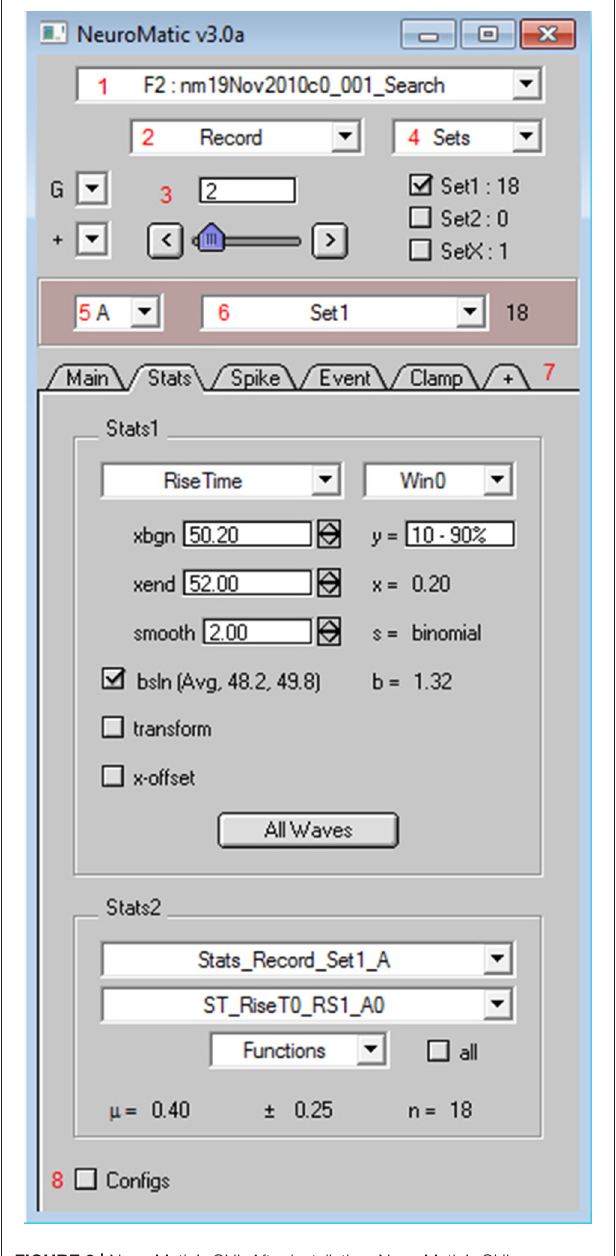
FIGURE 2 | NeuroMatic’s GUI. After installation, NeuroMatic’s GUI automatically appears once Igor starts. Red numbers (added to this screen capture) denote GUI controls of interest: (1) The folder select is used to specify which NeuroMatic data folder to analyze, or to execute a folder function such as Open, Save or New. NeuroMatic data folders contain acquired/simulated/imported waves, plus all variables, waves and subfolders necessary to run NeuroMatic. (2) The wave-prefix select is used to specify which waves in the selected folder are to be processed. For example, “Record” selects waves named “RecordA0,” “RecordA1,” etc. Selected waves are sorted alphanumerically via their channel letter (e.g., “A”) and sequence number (0, 1, 2, etc.). (3) The wave-number select controls (set-variable, slider, < > buttons) are used to specify the wave sequence number to display in NeuroMatic’s channel graphs ( Figure 3 ). (4) Data waves can be categorized into sets (e.g., Set1 or Set2) via checkboxes or the sets Edit Panel. Total